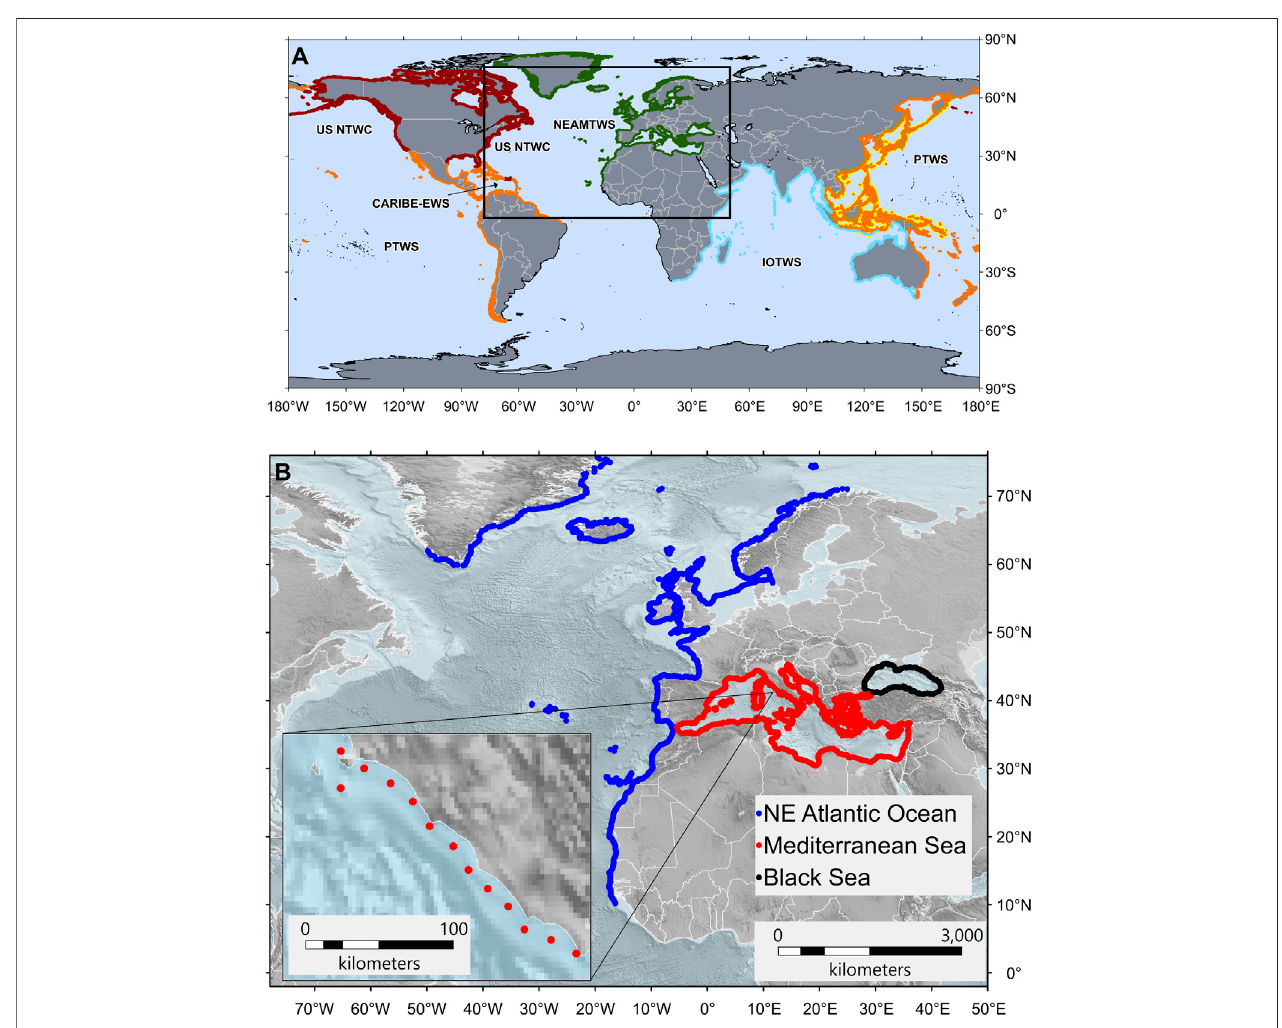
FIGURE1|(A) ICGsglobalareaofcoveragemapofTWS(IOC,2015).Theblackrectangleshowsthelocationofthemapinthelowerpanelcoveringalargepartof the NEAMTWS ( Table 1 ). US NTWC, US national tsunami warning center (brownish red) ; IOTWS, indian ocean tsunami warning and mitigation system (turquoise) ; PTWC, paci fi c tsunami warning center (orange) ; CARIBE-EWS: interim of PTWC and US NTWC; PTWS: Northwest Paci fi c Tsunami Advisory Center/Japan Meteorological Agency (yellow) , PTWC, and US NTWC. (B) Distribution of the Points of Interest (POIs) where the NEAMTHM18 hazard is calculated. The inset shows a close-up view of the POIs to appreciate their spacing and offshore location. Topo-bathymetry is from the ETOPO1 Global Relief Model (NOAA, 2009; Amante and Eakins, 2009).